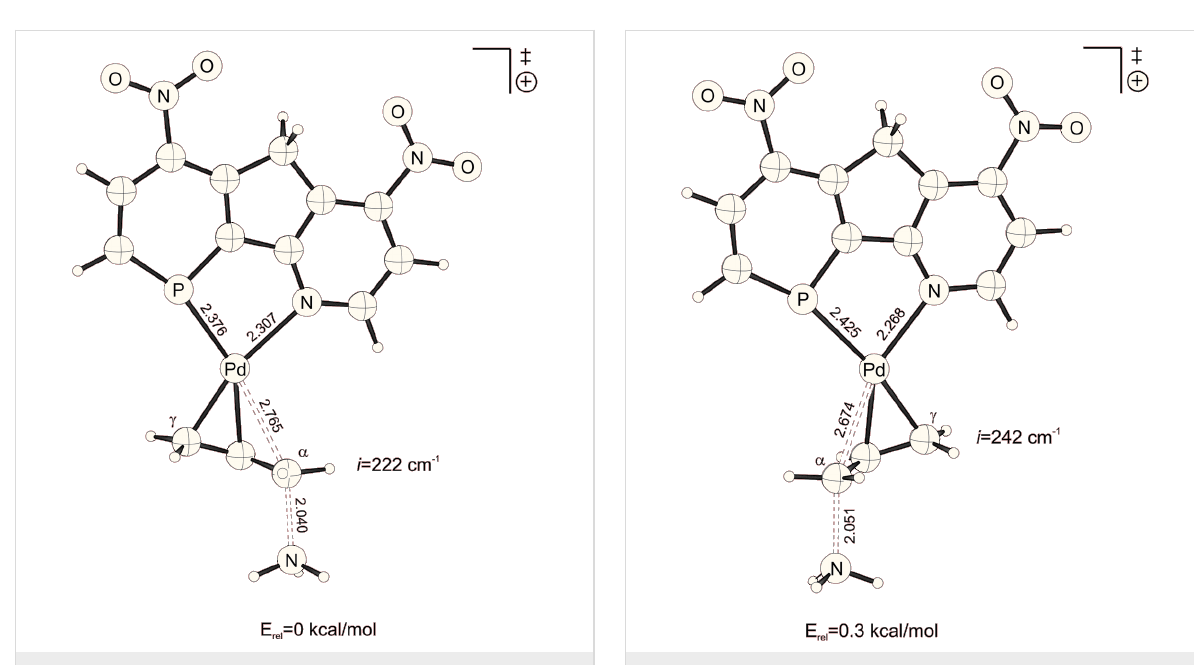
In agreement with the " trans to phosphorus" rule, [23-28] attack of ammonia is preferred for most X, Y combinations trans to P, due to the stronger π*/σ* acidity at P in phosphabenzene relative to N in pyridine (Table 1).[44] Surprisingly